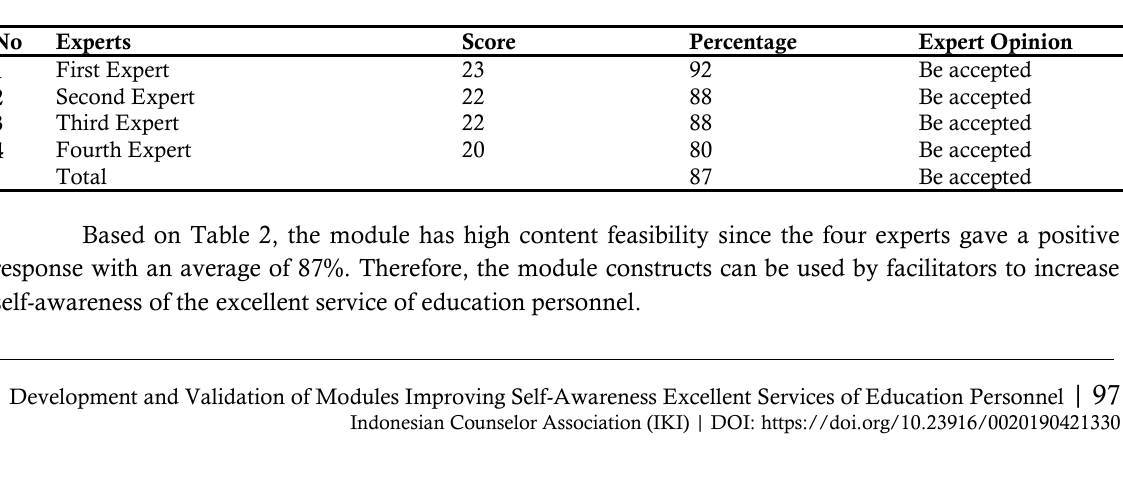
Table 2 . Feasibility Test Results of Product Content by